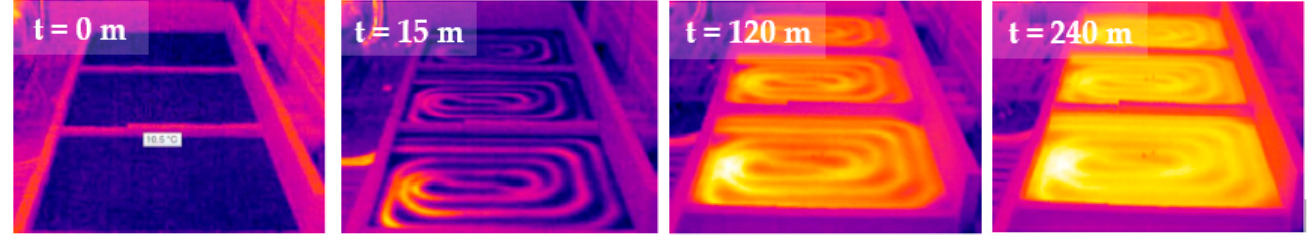
Figure 3. Thermal images taken throughout the heating period (m, minutes).